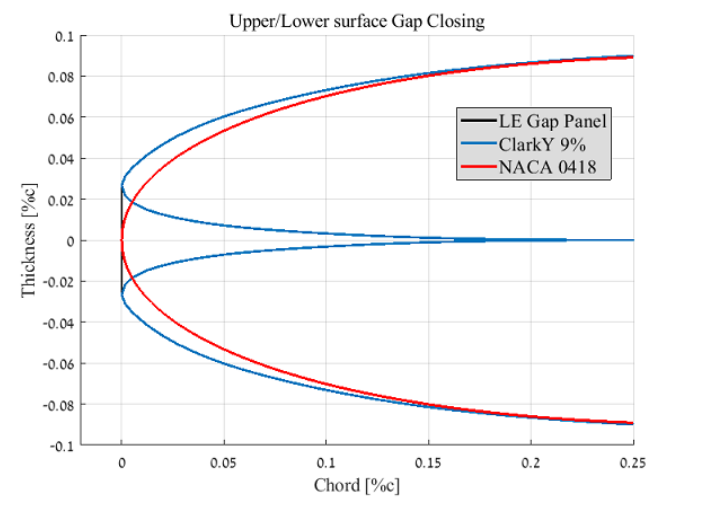
Figure 17. Closing of a ClarkY 9% airfoil using an upper or lower section and a NACA 4 digit